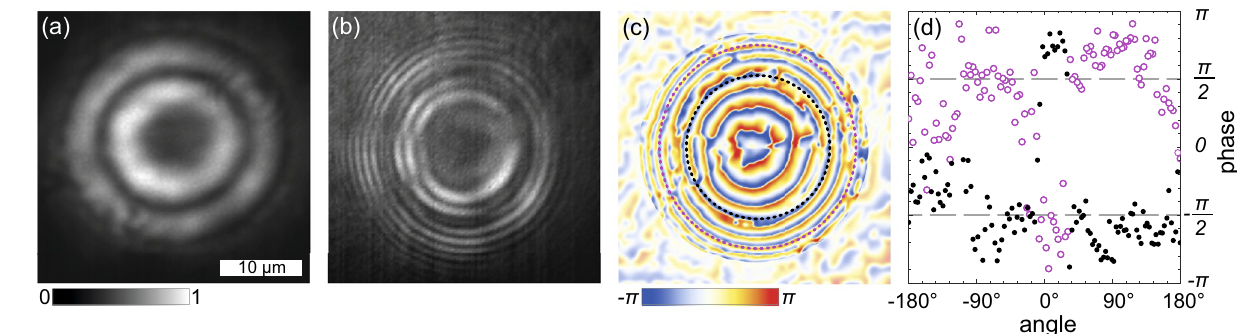
Figure 3. Observation of the concentric ring polariton condensate with oscillating vorticity. ( a ) Real-space image of time-averaged PL of the condensate, ( b ) the interferometry image obtained from the interference of PL of the condensate and the spherical reference wave, ( c ) the phase of the condensate relative to the phase of the reference wave extracted from panel ( b ), and ( d ) the phase variation around the condensate ring ridges indicated by black and magenta dashed circles in panel ( c ). Dashed lines are guides for the eye indicating π/ 2 constant phases ±